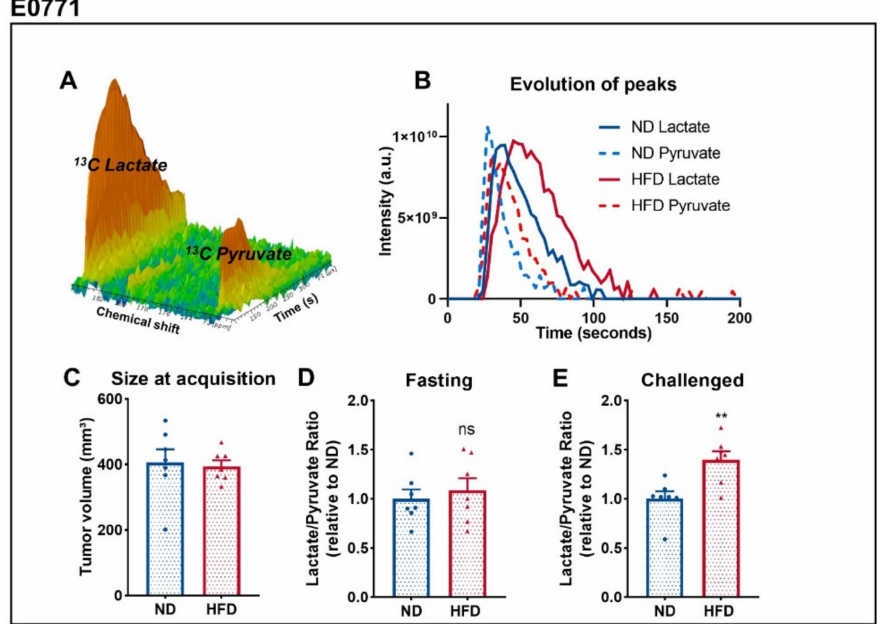
Figure 2. Breast tumors of obese mice display higher lac/pyr ratio than tumors of lean mice. ( A ) Rep- resentative MRS spectrum after injection of hyperpolarized 1- 13 C pyruvate acquired in vivo. ( B ) Rep- resentative evolution of 13 C pyruvate and 13 C lactate peaks over the time, from which the area under the curve and ratios are calculated. ( C ) Tumor size at the time of HP 1- 13 Cpyruvate-to-lactate spectra acquisition of E0771 tumors measured by T2-weighted MRI images. ( D ) Calculated Lac/Pyr ratio in fasted mice and ( E ) mice challenged with glucose. Sample size: n = 7 for ND and n = 7 for HFD, failure to acquire spectrum from a mouse from HFD. Statistical analysis: unpaired t -test; ns p > 0.05; ** p <